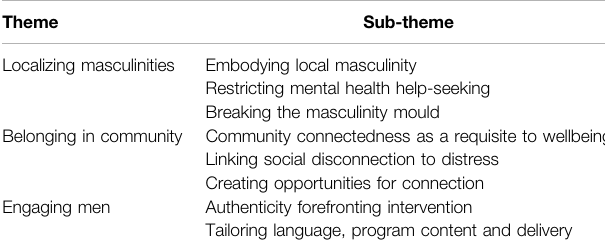
TABLE 1 | Summary of themes and